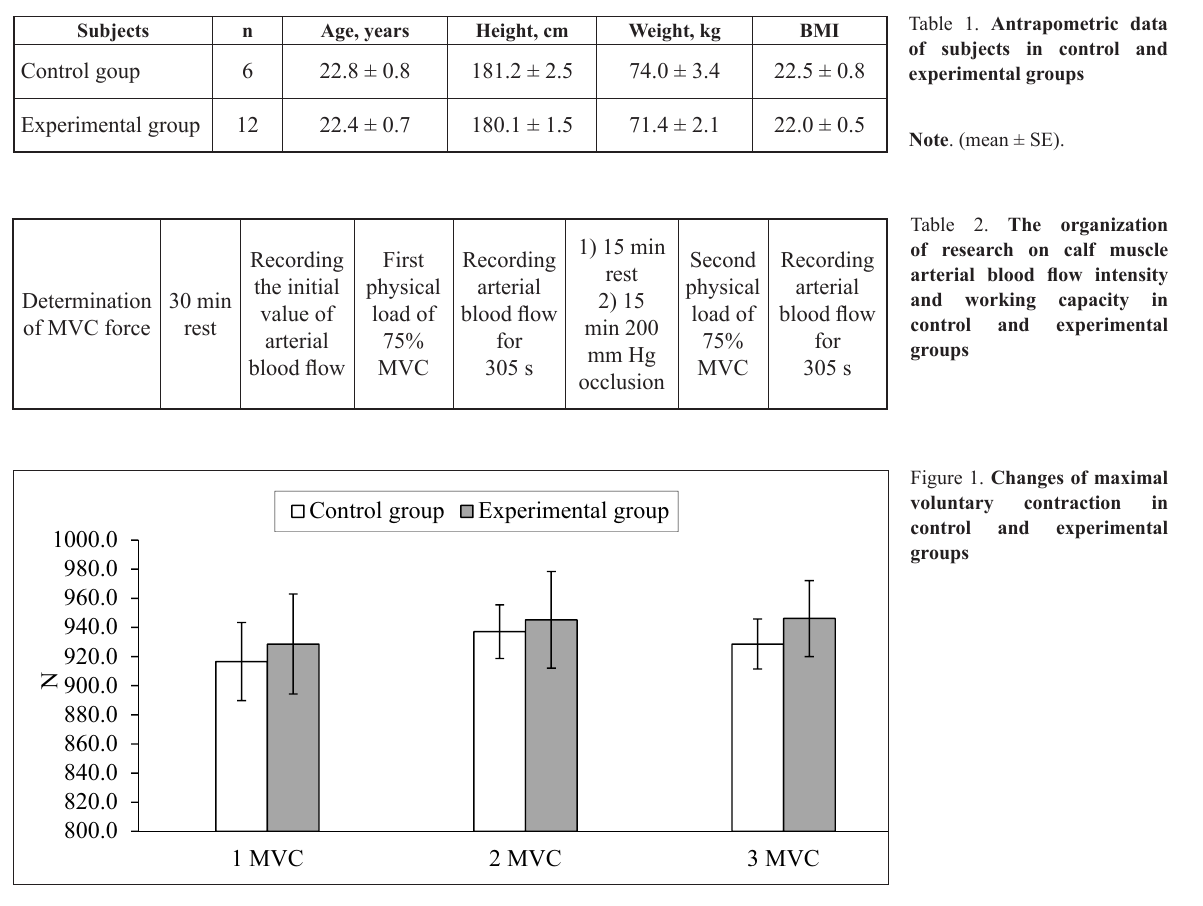
Figure 1. Changes of maximal voluntary contraction in control and experimental groups